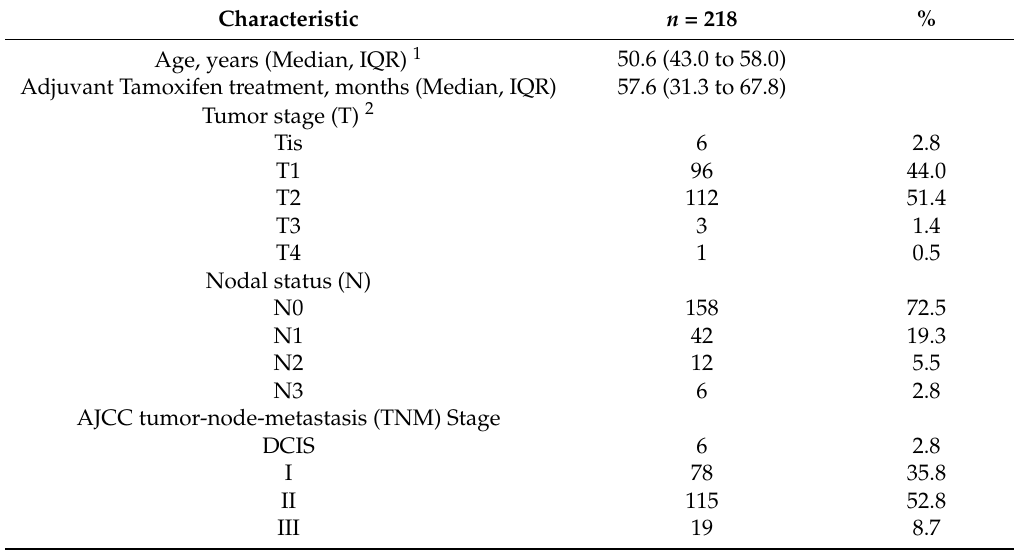
Table 1. General characteristics of 218 estrogen receptor (ER)-positive breast cancer patients receiving adjuvant tamoxifen